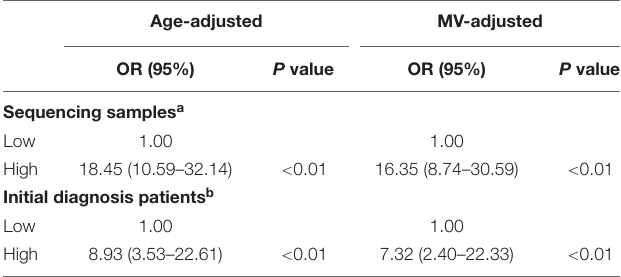
TABLE 2 | Age and multivariable (MV)-adjusted odds ratios for the association between immune risk score and melanoma